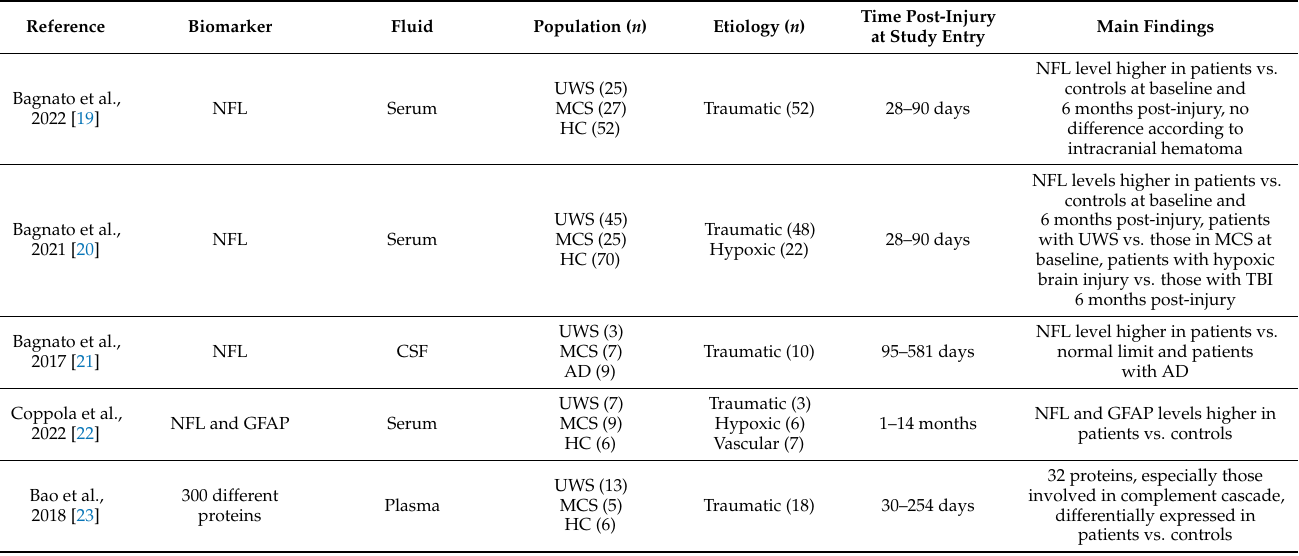
Table 1. Summary of studies evaluating CSF and blood biomarkers in patients with prolonged